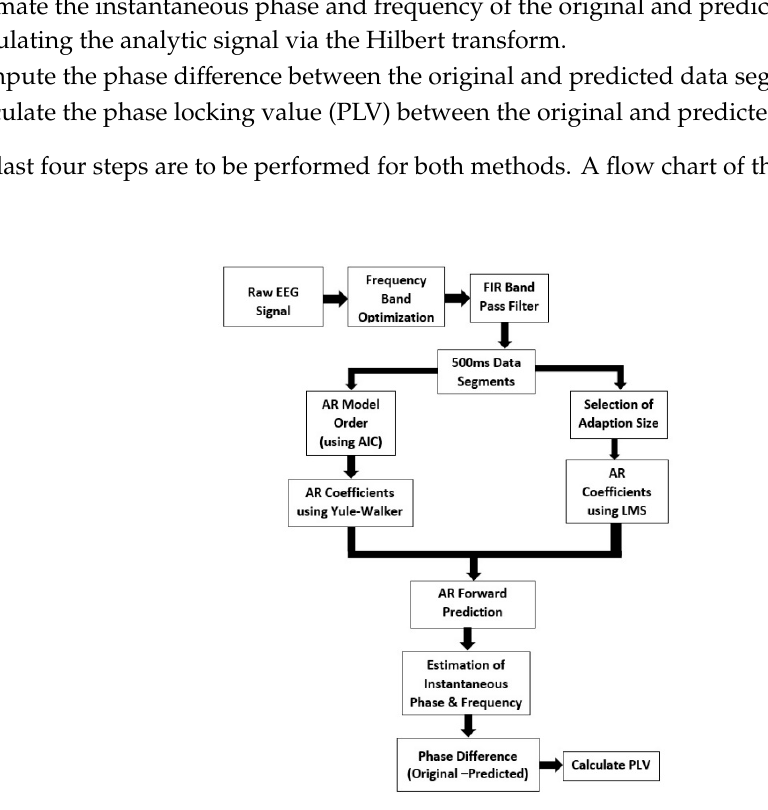
Figure 2. Algorithm Overview. The flow chart shows the sequential steps. The first four steps and the last four steps are the same for both the AR model and the least mean square (LMS)-based AR